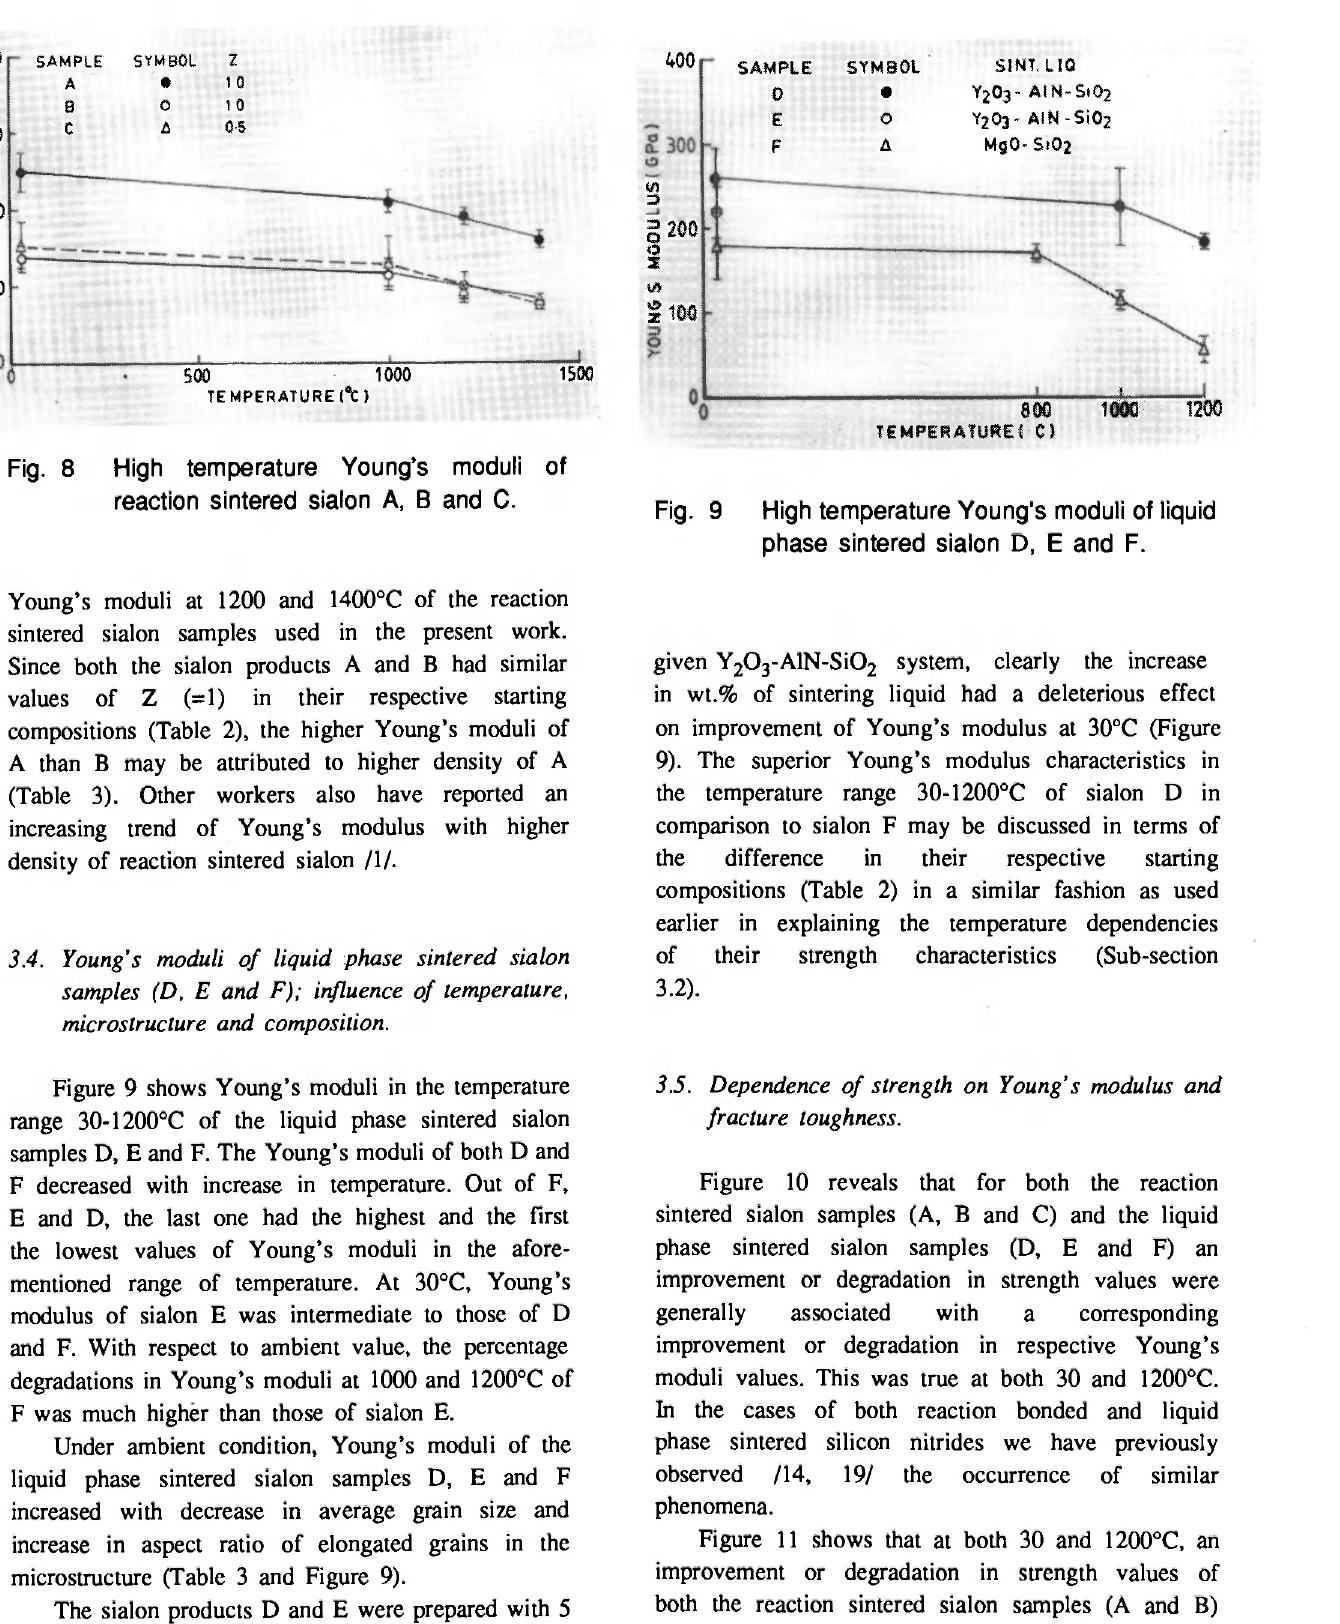
phase sintered sialon D, Ε and